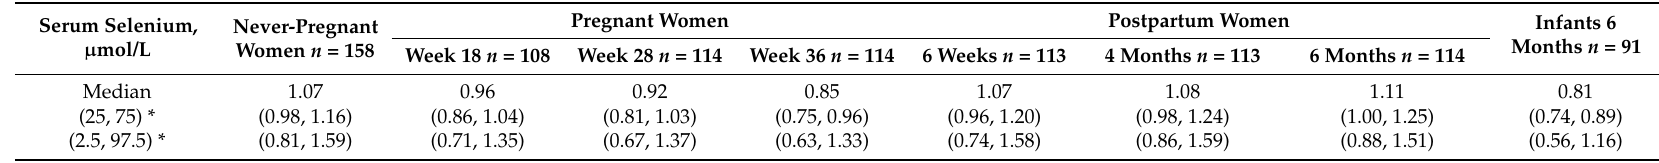
Table 2. Serum selenium levels in never-pregnant women, women during pregnancy and postpartum, and infants at 6 months. Serum Selenium, µ mol/L